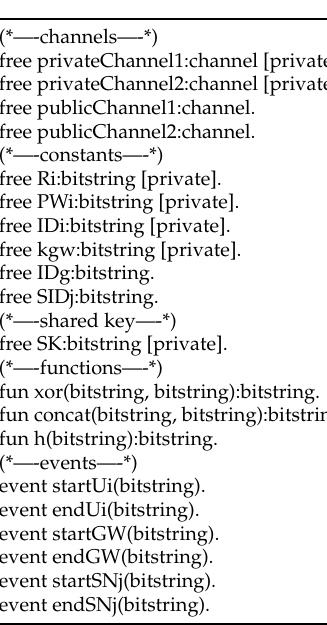
Table 5. Definitions of channels, variables and other related parameters.